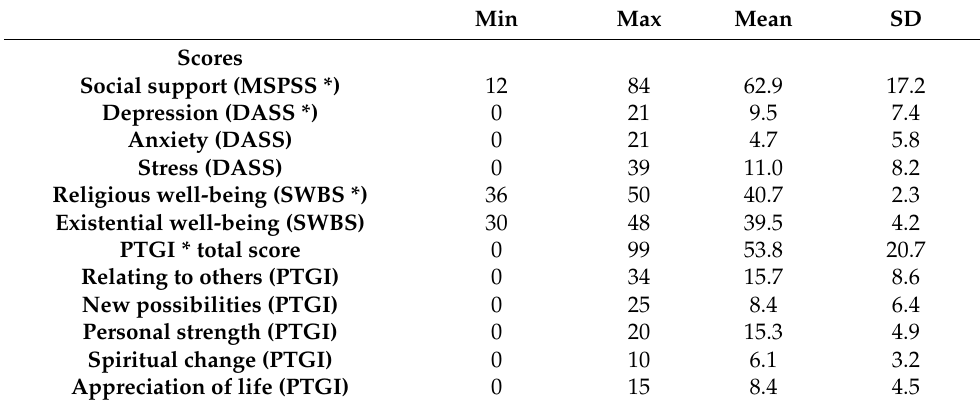
Table 2. Mean scores and standard deviations of study variables.